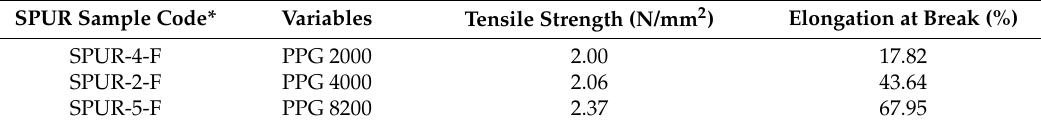
Table 8. The mechanical test results of cured SPUR with different PPG chain length.